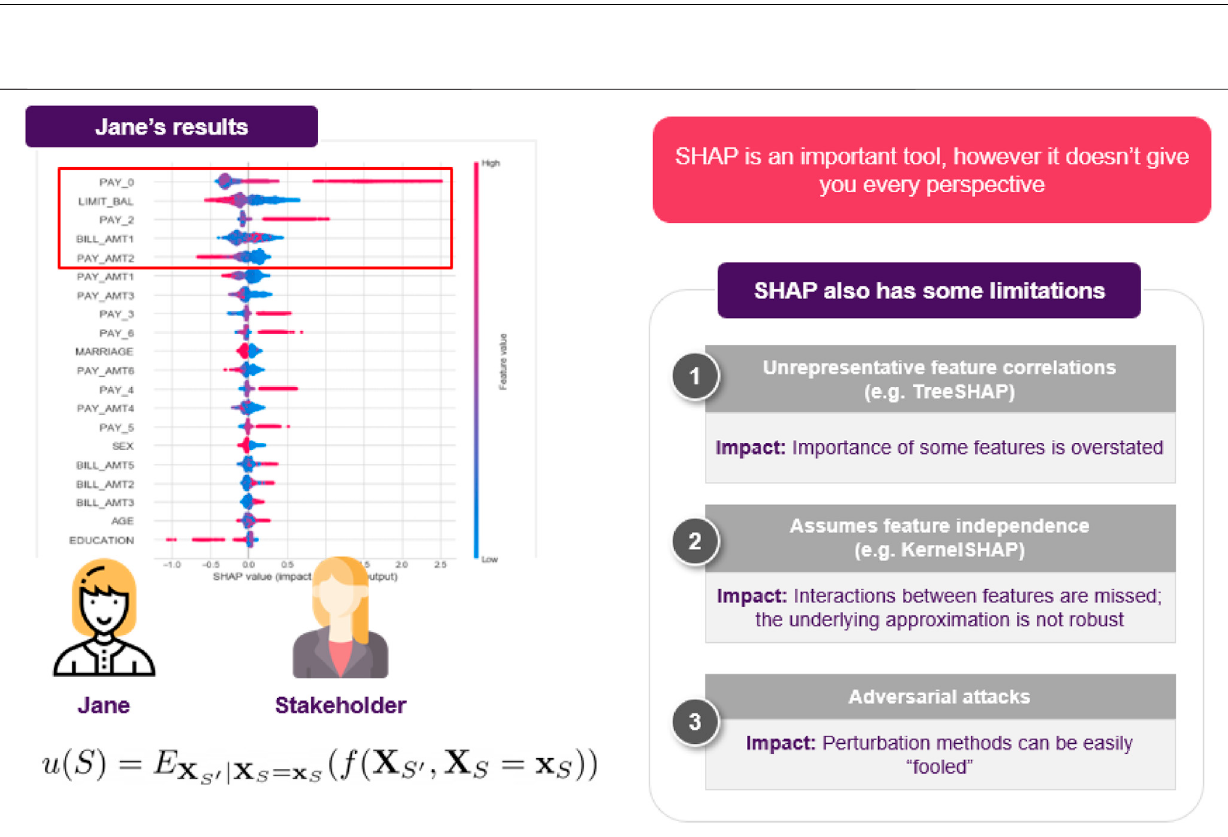
Frontiers in Big Data |